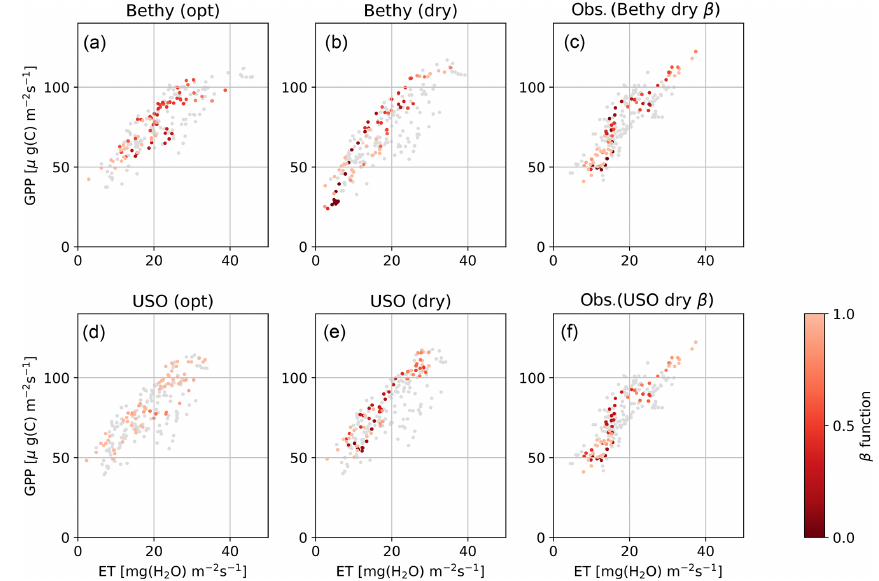
Figure 4. Hyytiälä site water use efficiency for the Bethy and USO formulations. Scatter-plotted are the dry-period 5d running averages of ET and GPP, coloured by the intensity of the drought ( β function). Panels (a, d) depict the model with the more generally optimised parameter values and (b, e) with the drought optimisation, and (c, f) present the corresponding observations, coloured by the same intensity as in (b, e) . The grey points are from the corresponding time during the 2 previous